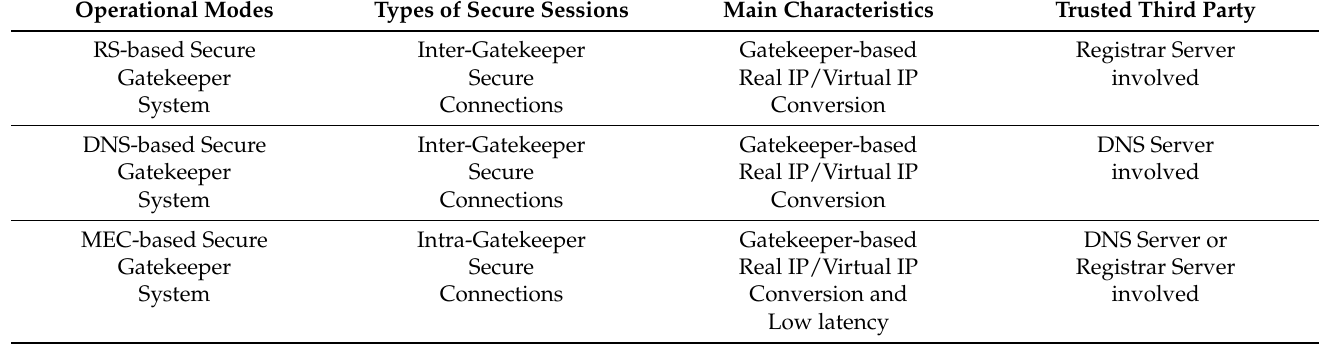
Table 1. Three different operational modes of the secure gatekeeper system.